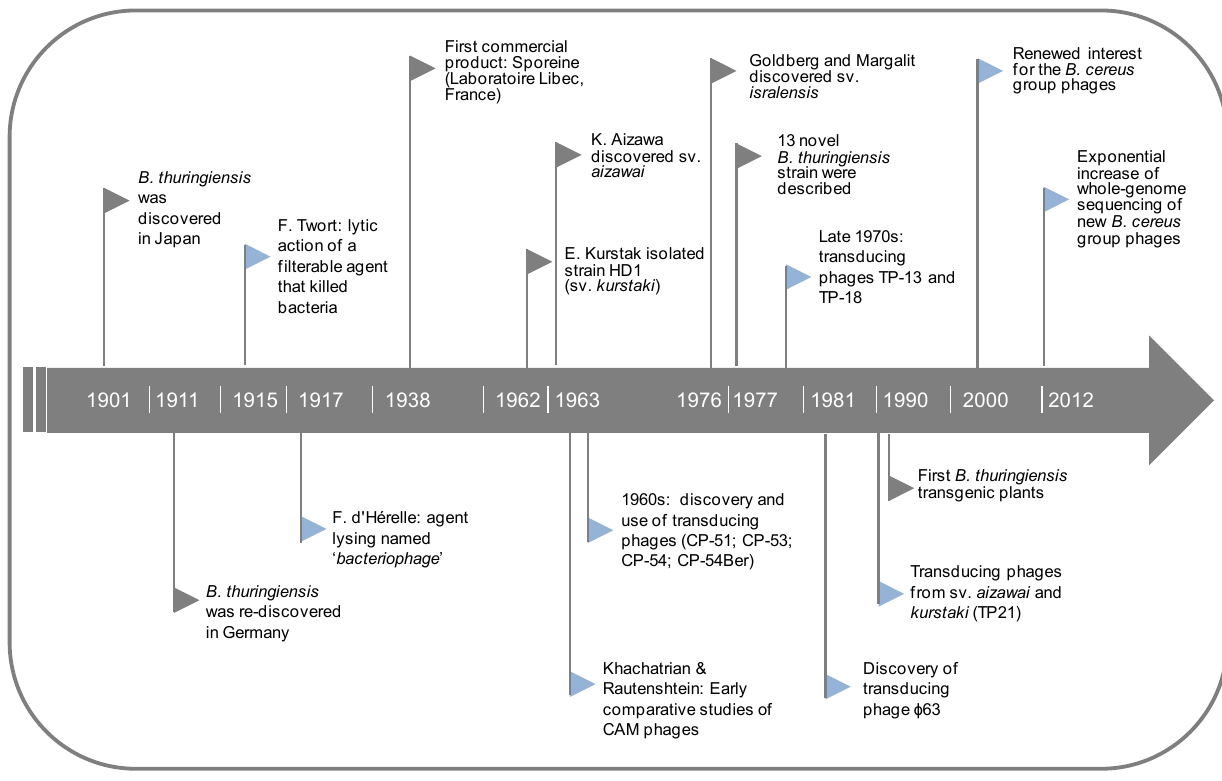
Figure 1. Timeline displaying the main milestones for B. thuringiensis research (grey flags) alongside the discovery of its phages (blue